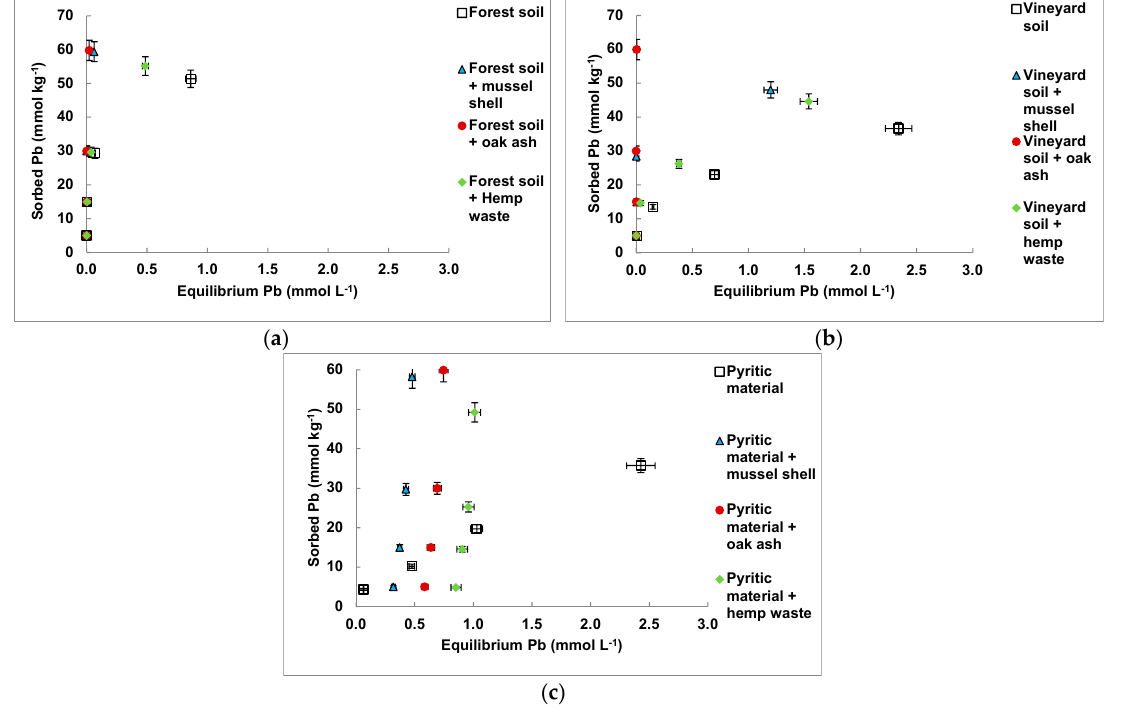
Figure 4. Pb sorption curves for the non-amended and amended forest soil ( a ), vineyard soil ( b ), and pyritic material ( c ). Average values (with error bars) for three replicates, with coefficients of variation always <5%.